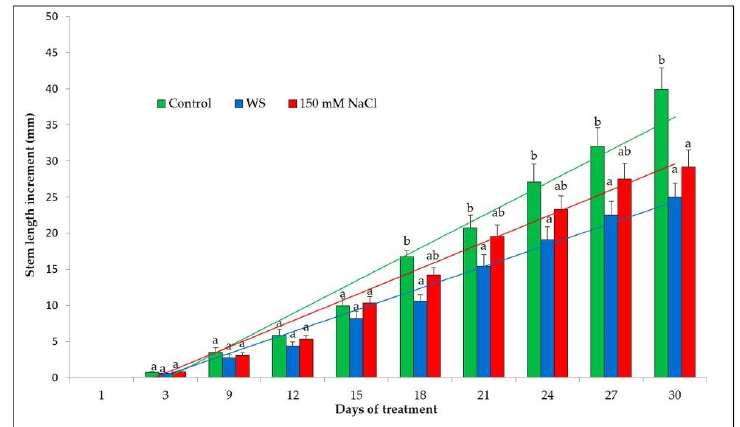
Figure 2. Effect of 30 days of water (WS) and salt (150 mM NaCl) stress treatments on stem elongation in Larix decidua . Stem length measurements were taken every three days. Bars represent means with SE ( n = 7). Different letters above the bars indicate significant differences between treatments, according to Tukey’s test ( α = 0.05).